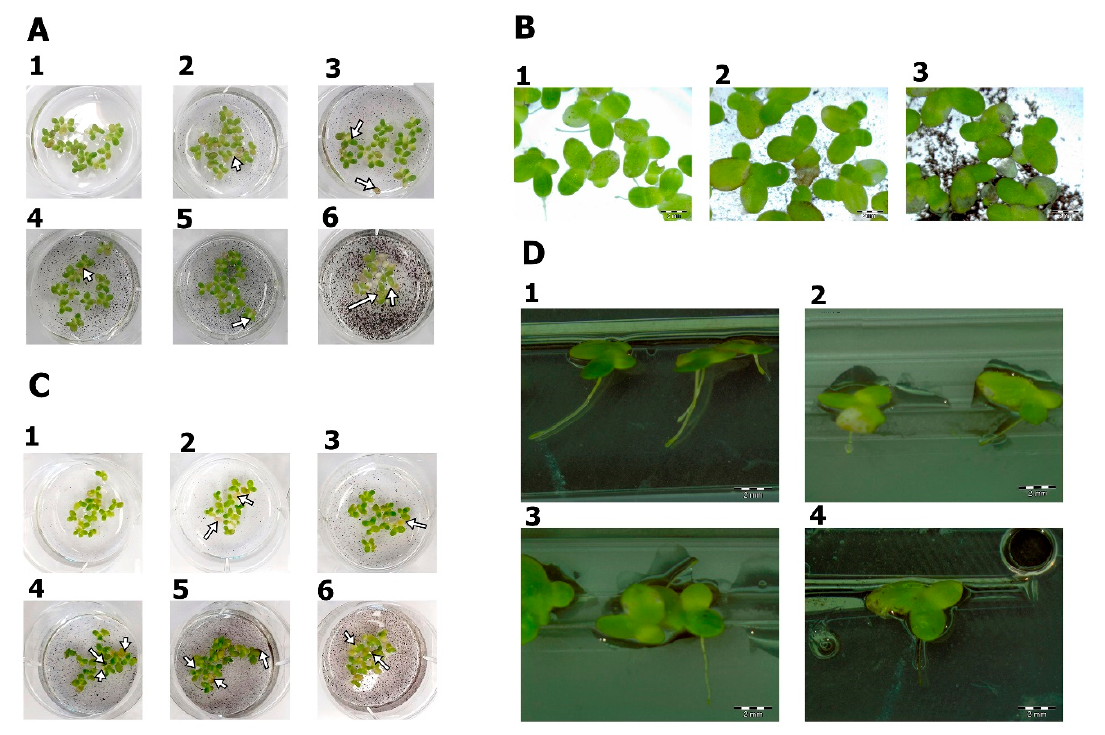
Figure 7. Lemna minor morphology after PG and GO treatment. ( A1 , B1 , C1 , D1 ) Control group; ( A2 – A6 , B2 , D2 ) after PG treatment; ( C2 – C6 , B3 , D3 , D4 ) after GO treatment. White arrows indicate frond damage.